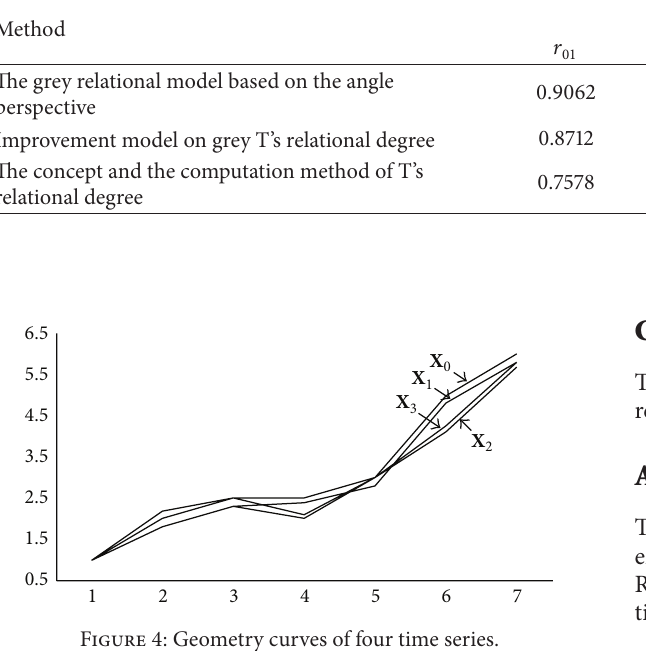
Figure 4: Geometry curves of four time